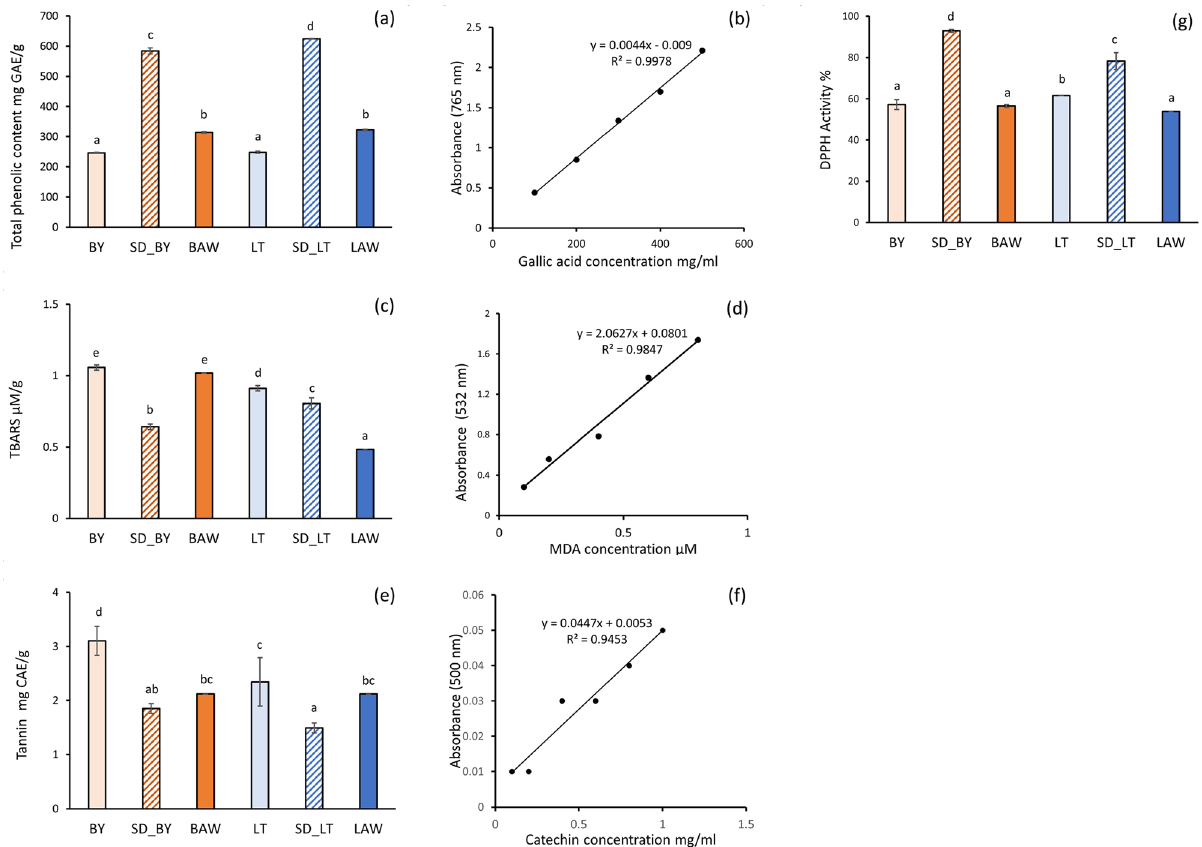
content ( f ) Catechin calibration curve ( g ) DPPH activity. Significant differences among samples are expressed by different lowercase letters. Legend: Antioxidant and antinutritional properties of the powder samples. BY: plain Barnyard millet flour; LT: plain Little millet flour; SD_BY: spray dried Barnyard millet soluble fraction; SD_LT: spray dried Little millet soluble fraction; BAW: 25% w/v Barnyard millet + acid whey; LAW: 25% w/v Little millet + acid